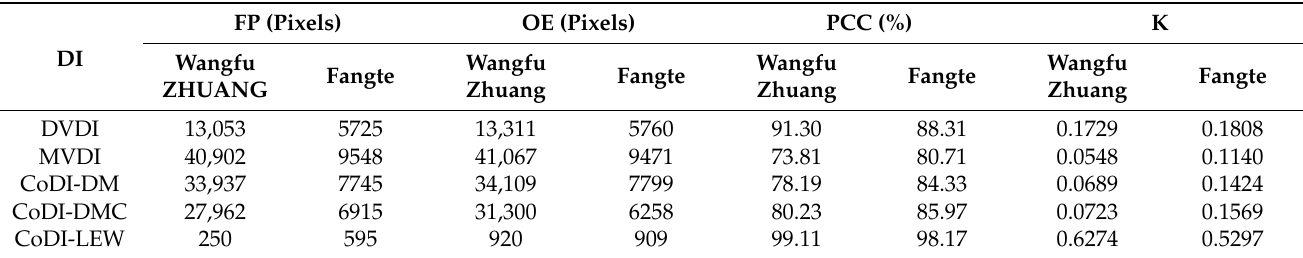
Table 1. The accuracy of change detection based on different methods in Fangte and Wangfu Zhuang Stations.